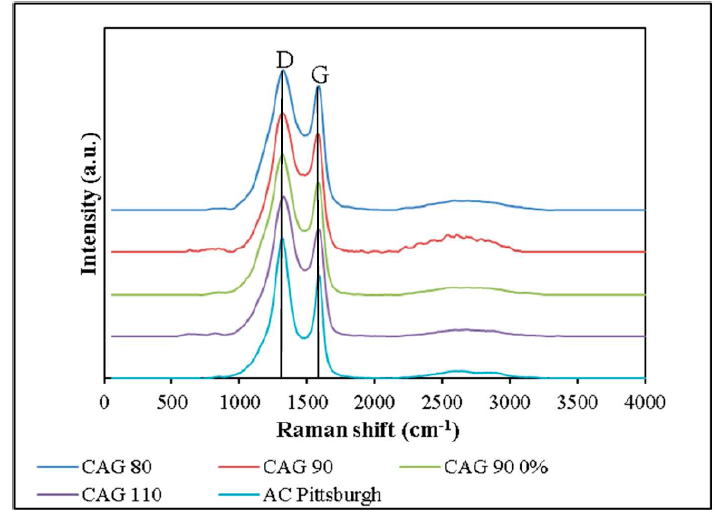
Figure 6. Normalized Raman spectra for CAG 80, 90, 90 0%, 110, and commercial activated carbon Pittsburgh.